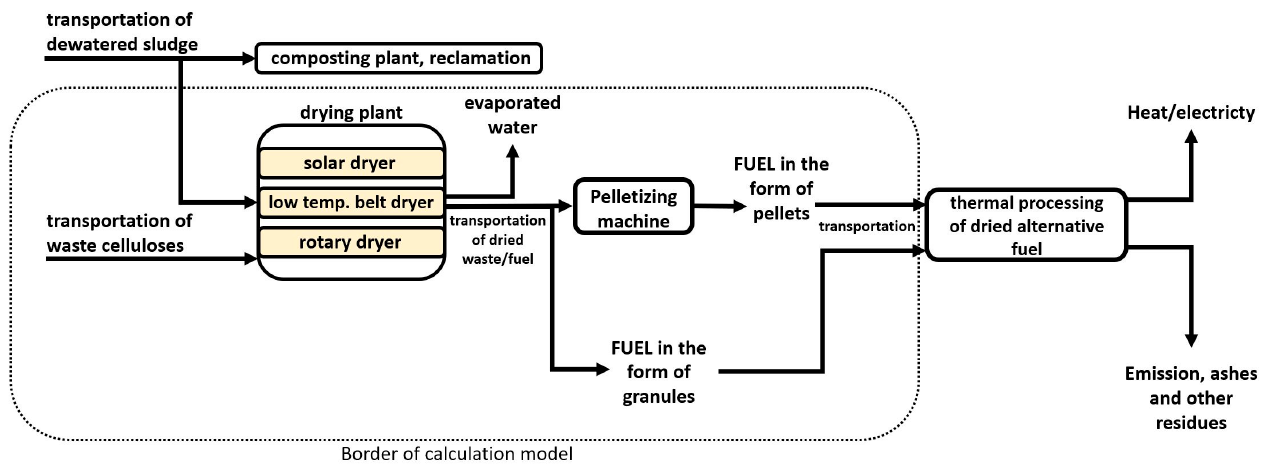
Figure 1. Technology of production of fuel from a mixture of sewage sludge and waste